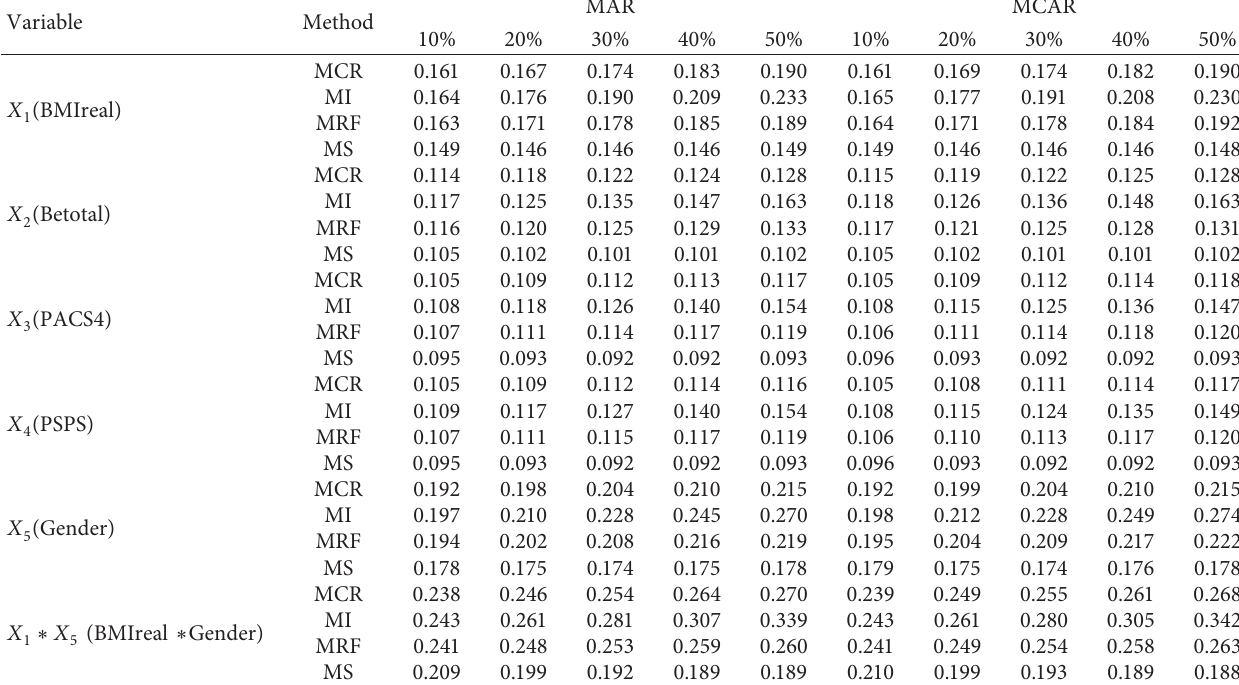
Table 4: Comparison of the performance of imputation methods based on the model based SE of regression coefficients over 1000 simulations.